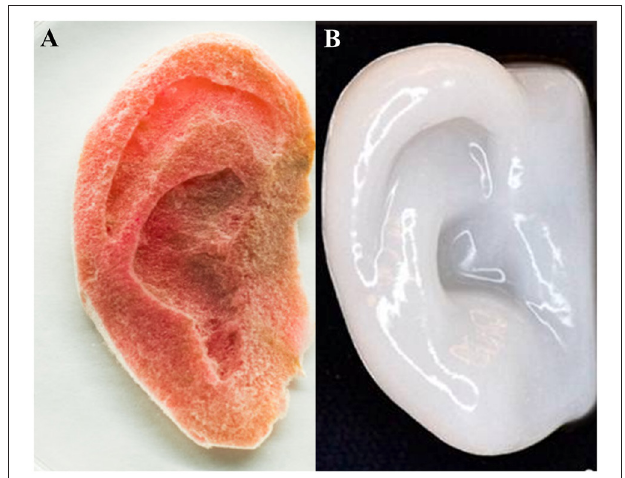
FIGURE 5 | Human ear scaffolds carved out of plant based cellulose (A) and 3D printed with nanofibrillated cellulose both cultured with human cells (HeLa and chondrocytes, respectively). (A) (Hickey et al., 2018), Copyright 2018. Reproduced with permission from American Chemical Society. (B) ( Markstedt et al., 2015), Copyright 2015. Reproduced with permission from American Chemical